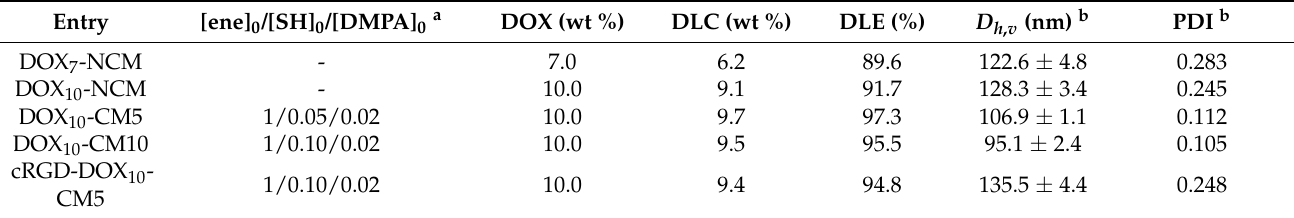
Table 3. Preparation conditions and characterization of DOX-loaded pH-responsive micelles.